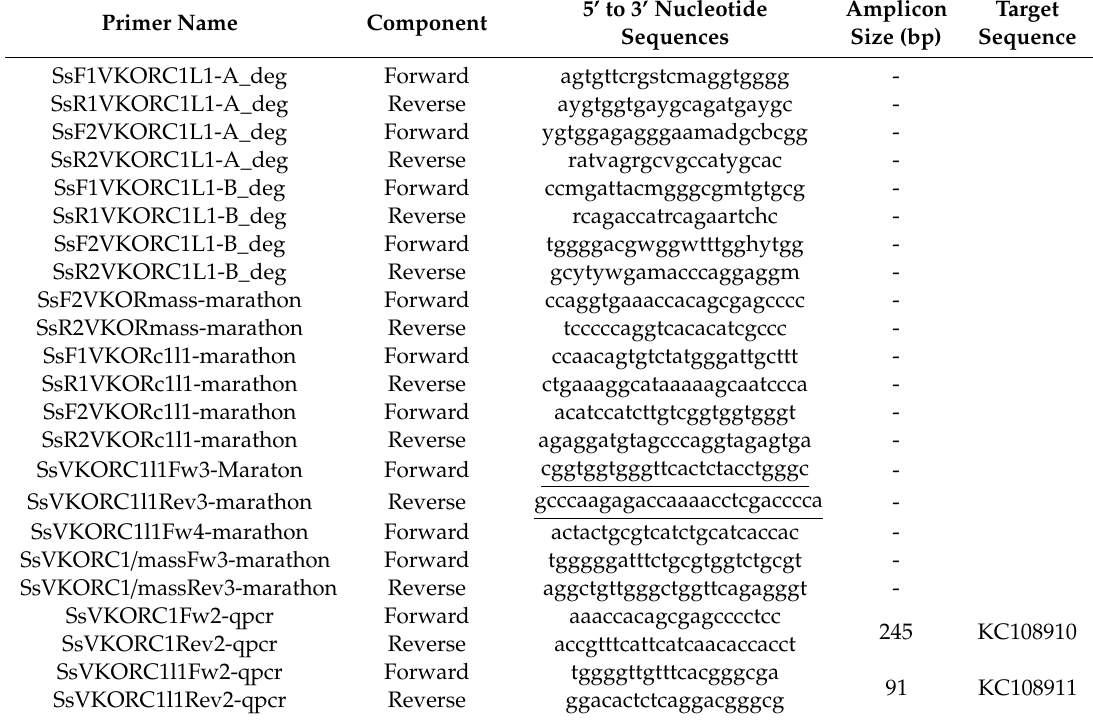
Table 1. Designed primers for initial amplification of Senegalese sole vkors cDNA sequences, full-length amplifications and relative gene